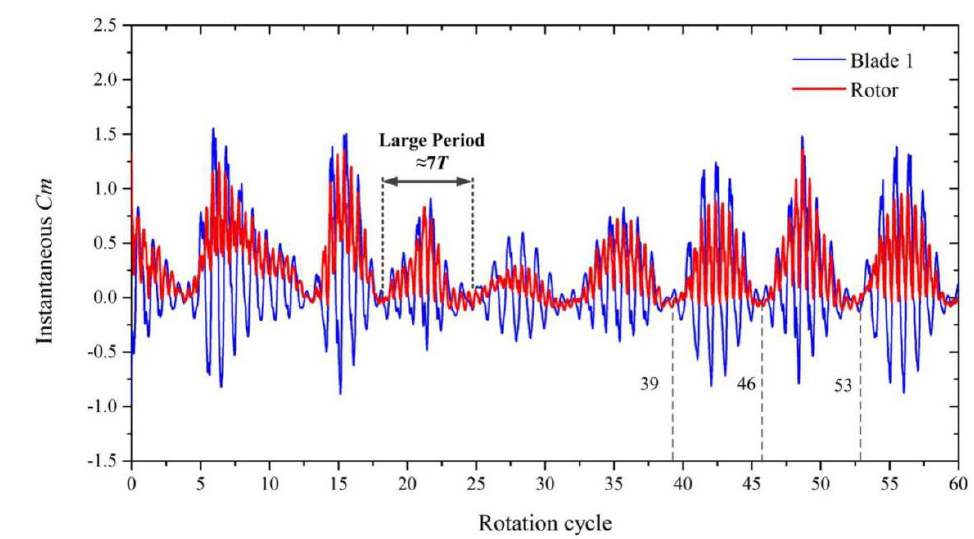
Figure 23. Instantaneous coefficients of torque on both the blade and the turbine at TSR = 0.4 and φ = 157.5°.